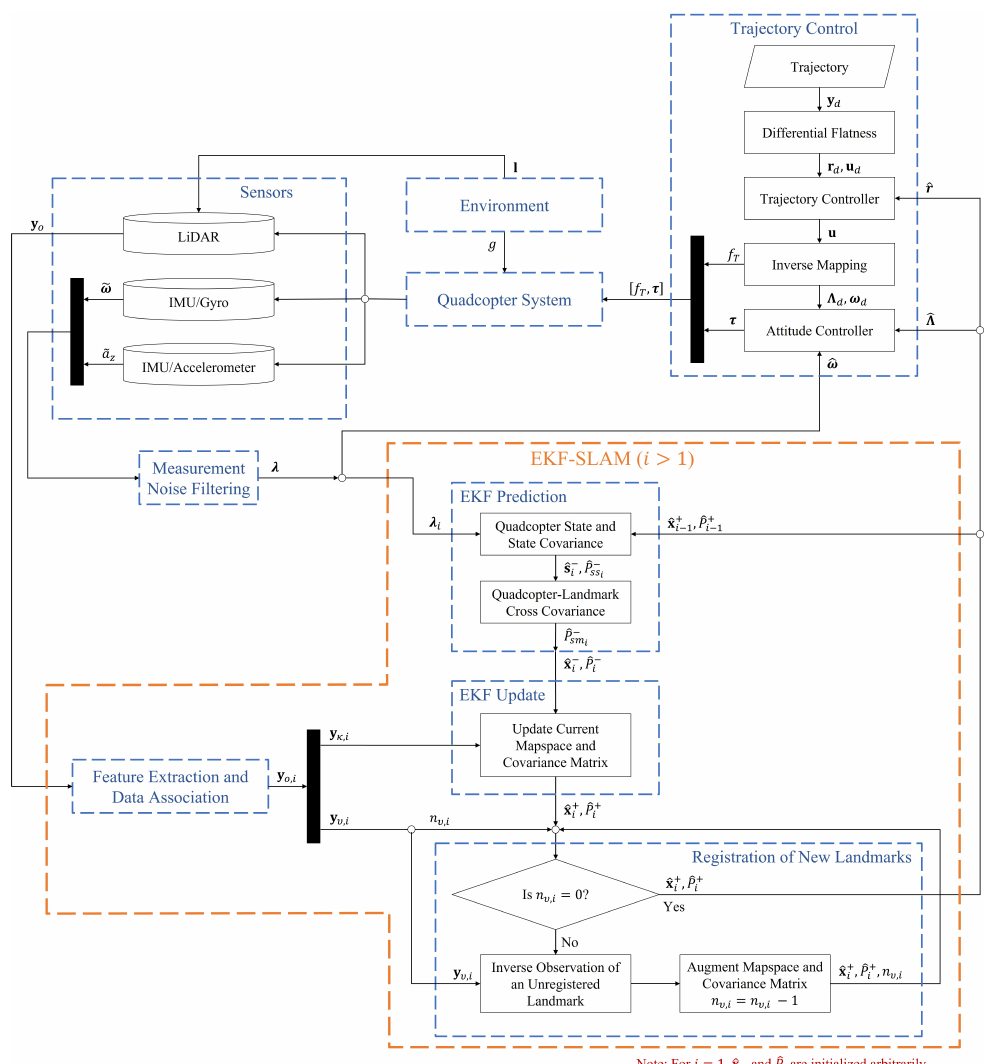
Figure 4. EKF-SLAM flowchart in the sensing, navigation, and control